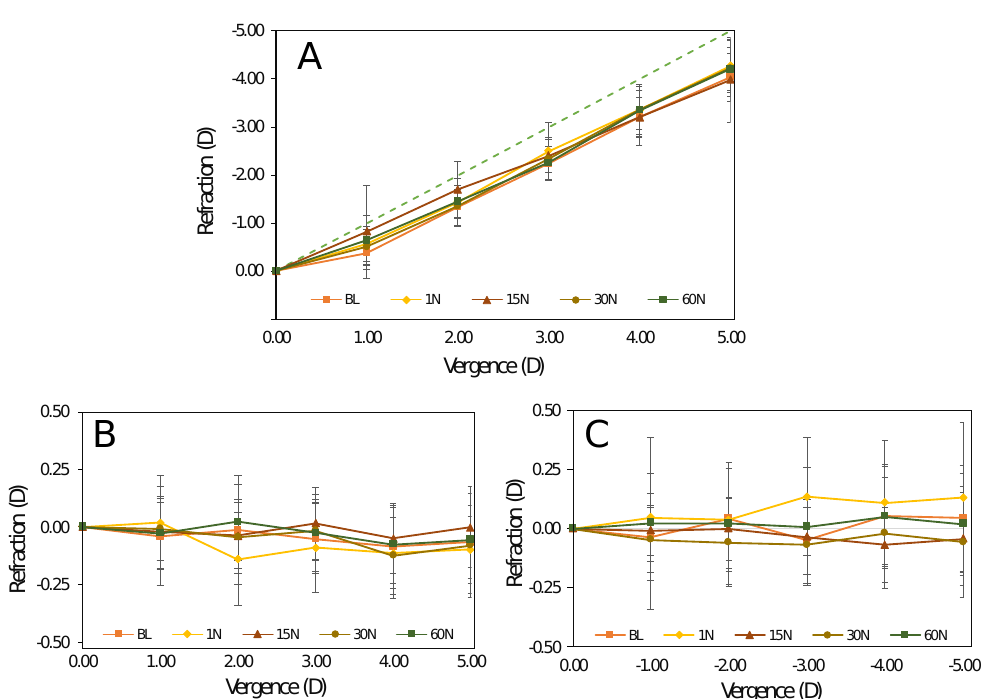
Figure 3. Accommodative response at BL and after 1, 15, 30, and 60 nights of OK lens wear for the spherical equivalent ( A ), J0 component ( B ), and J45 component ( C ). Errors bars represent the standard deviation.